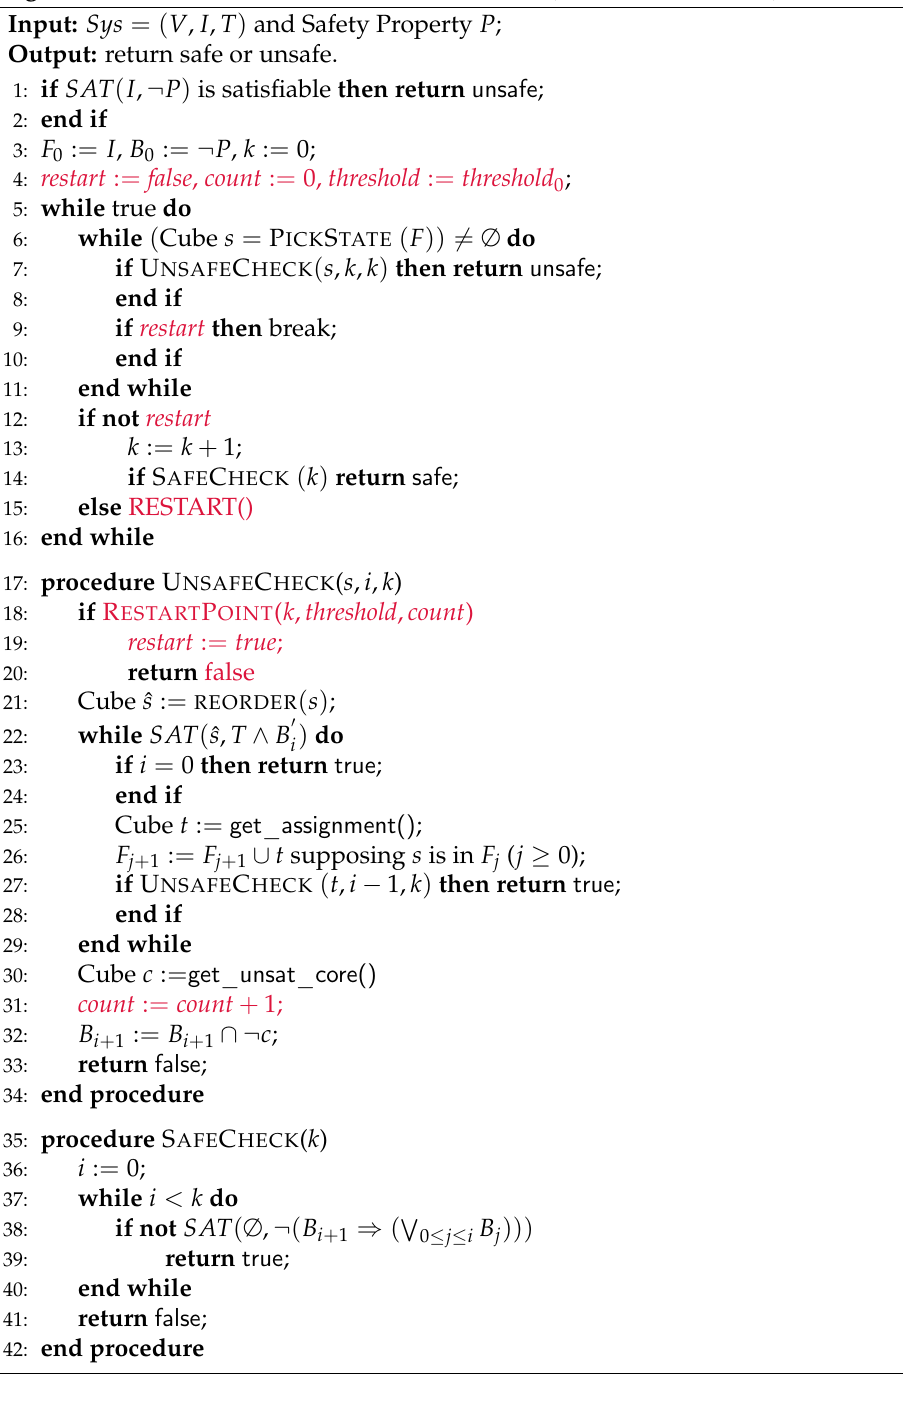
Algorithm 1 Main Procedures of r-CAR and CAR (without texts in